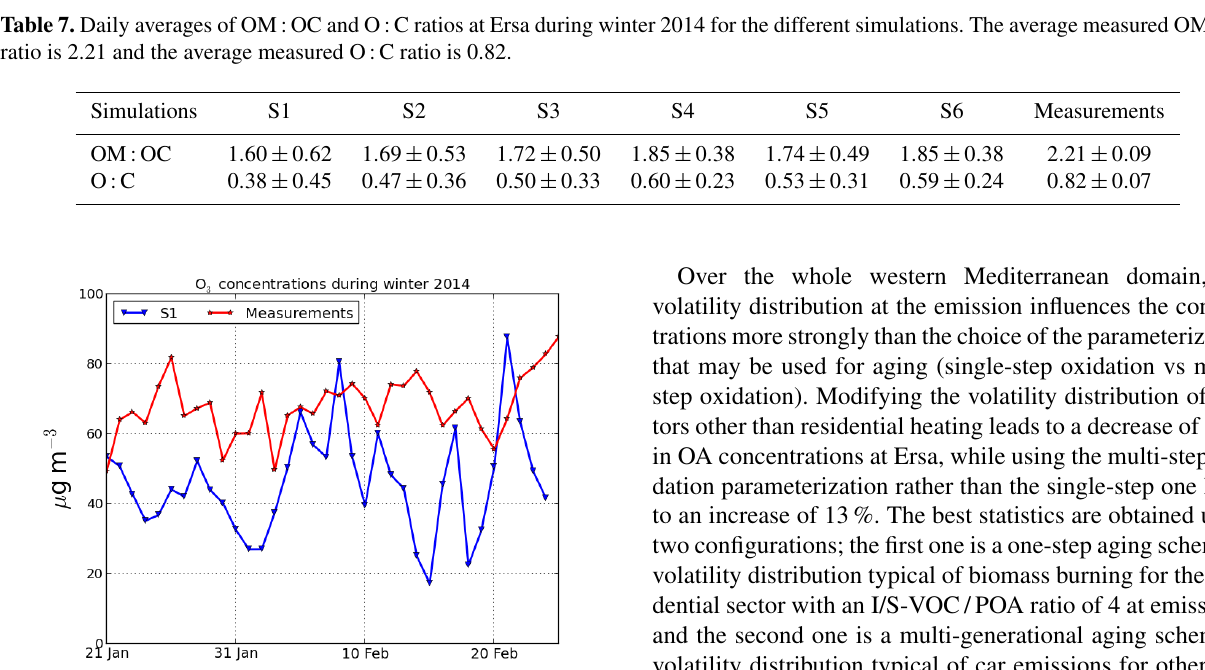
Figure 5. Daily evolution of ozone concentrations from 21 January to 24 February 2014 at